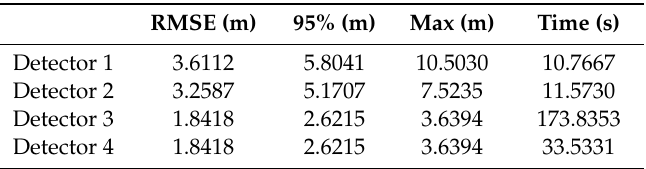
Table 3. The numerical results of the four detectors in Case 1.